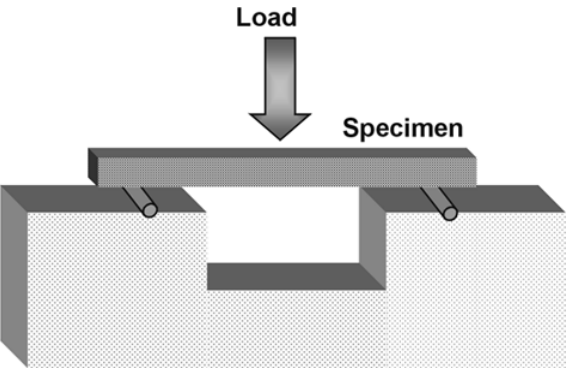
FIGURE 4- Schematic illustration of diametral compression